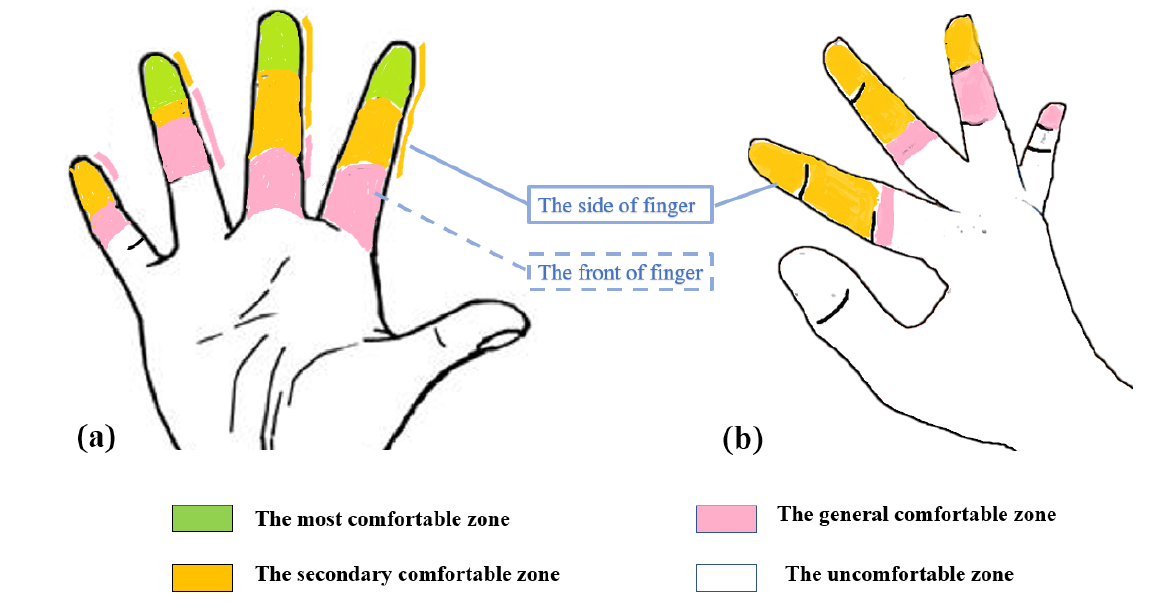
Figure 8. Zones of the different level of comfort on right hand. ( a ) The heat map of the front of fingers; ( b ) The heat map of the side of